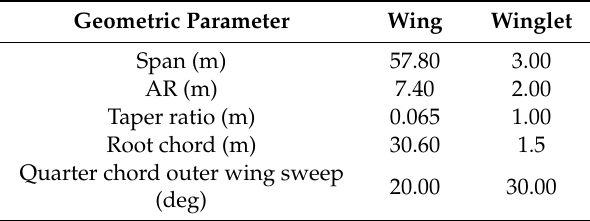
Table 3. Wing and vertical tail geometric properties.